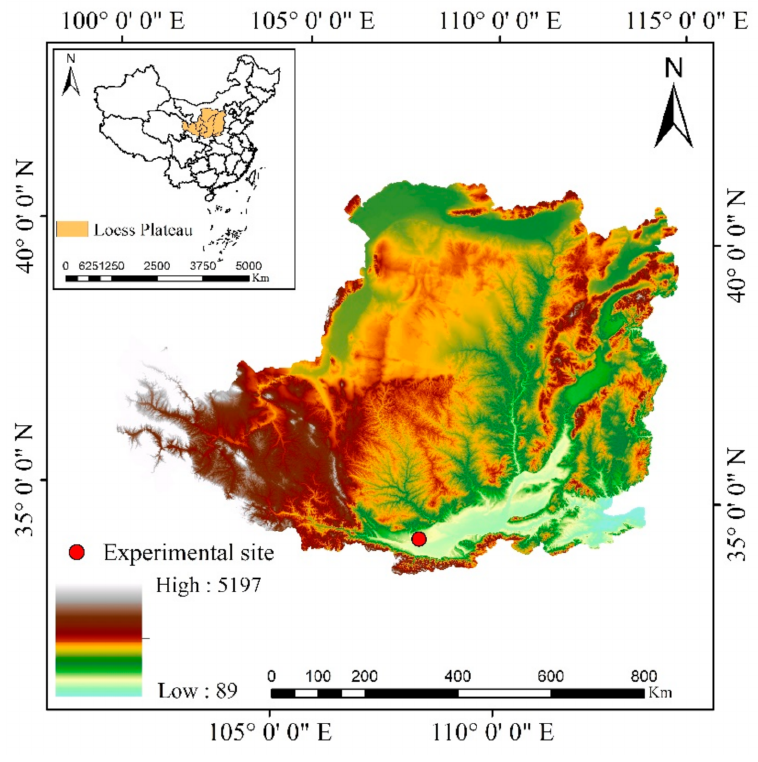
Figure 1. Location of the experimental site.